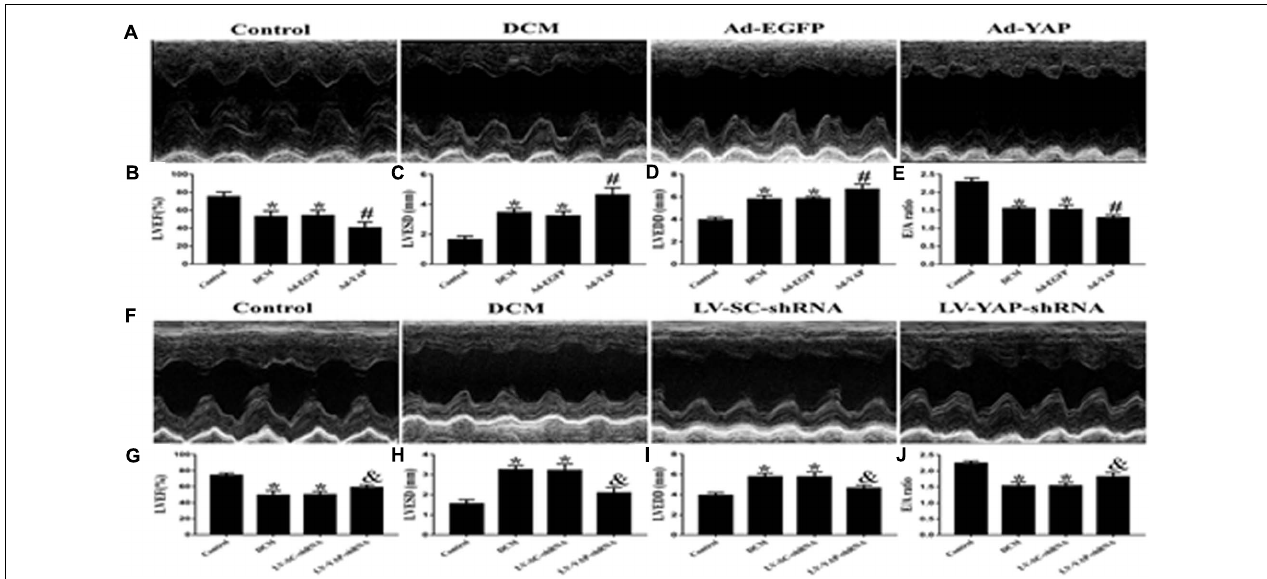
FIGURE 5 | The effect of YAP overexpression or YAP silence on the cardiac function in rats with diabetic cardiomyopathy in two separate experiments. (A) M-mode echocardiograms in the 4 groups (Ad-YAP group, Ad-EGFP, DCM, and Control group) ( n = 4). (B) (LVEF) in the 4 groups. (C) LVESD in the 4 groups. (D) LVEDD in the 4 groups. (E) E/A ratio respective levels in the 4 groups. (F) M-mode echocardiograms in the 4 groups (LV-YAP-shRNA group, LV-SC-shRNA group, DCM group and Control group). (G) LVEF in the 4 groups. (H) LVESD in the 4 groups was increased compared to that in the DCM group and the LV-SC-shRNA group. (I) LVEDD in the 4 groups. (J) E/A ratio respective levels in the 4 groups. * p < 0.05 versus the control group in the lower panels; # p < 0.05 versus the Ad-EGFP group; & p < 0.05 versus the LV-SC-shRNA group.